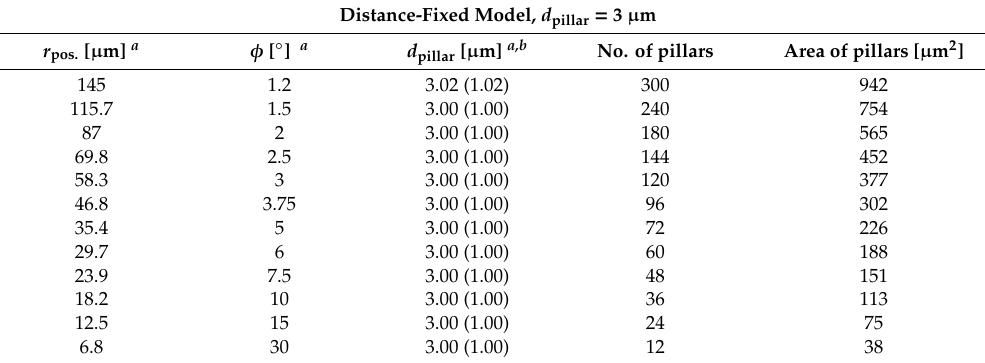
φ , and d a r pos. , pillar are denoted in Figure 3a. neighboring pillars (d pillar − 2 × r pillar